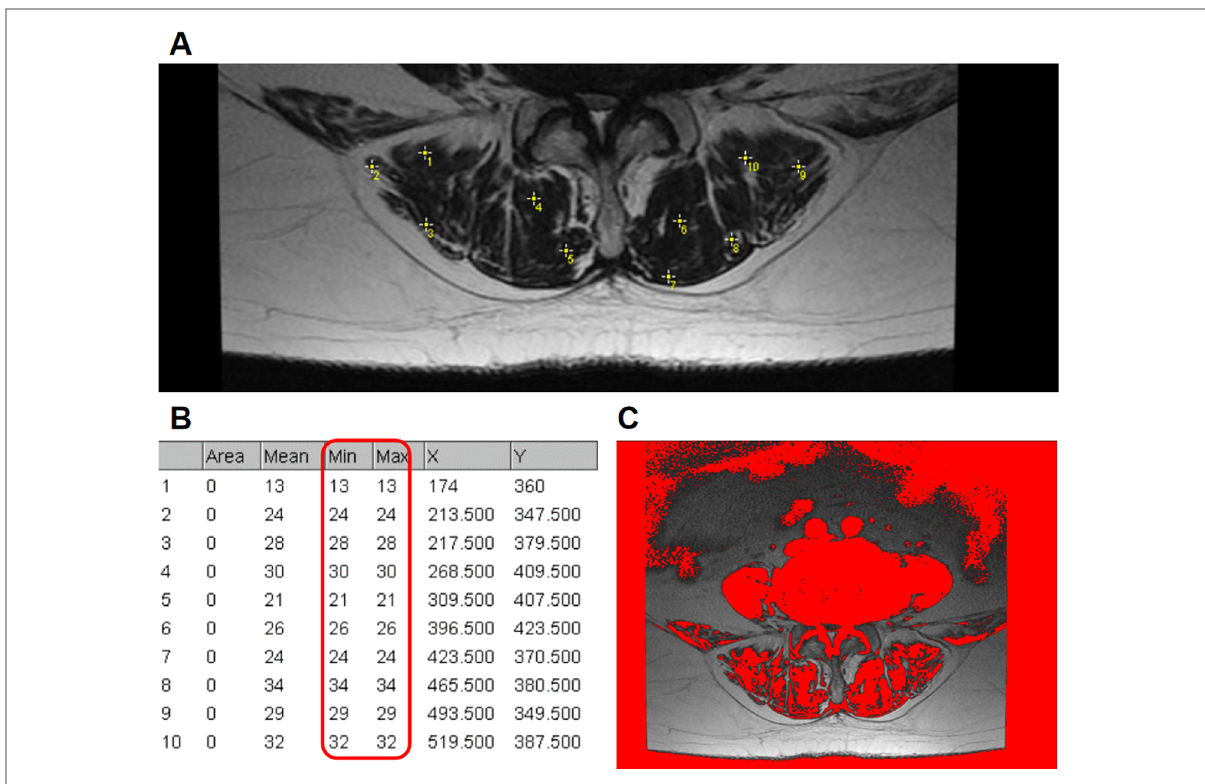
FIGURE 1 Use of the “ Multi-point ” tool to determine the threshold to distinguish lean muscle tissue from fat tissue. ( A ) Ten sample points without any visible pixel of fat tissue within the bilateral paraspinal muscle were selected. ( B ) The maximum signal intensity of the ten points was determined as the threshold. ( C ) An example axial T2 weighted MR image of the functional cross-sectional area of the muscles (red area), using the threshold